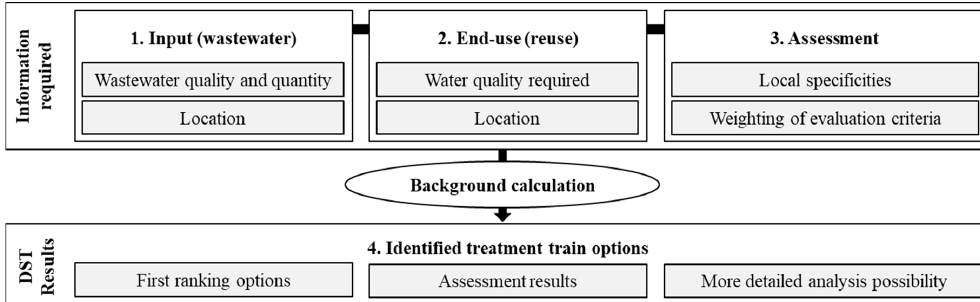
Figure 2. The architecture of the decision support tool (DST) Poseidon requires limited information from the user to calculate and present most adequate treatment trains according to local